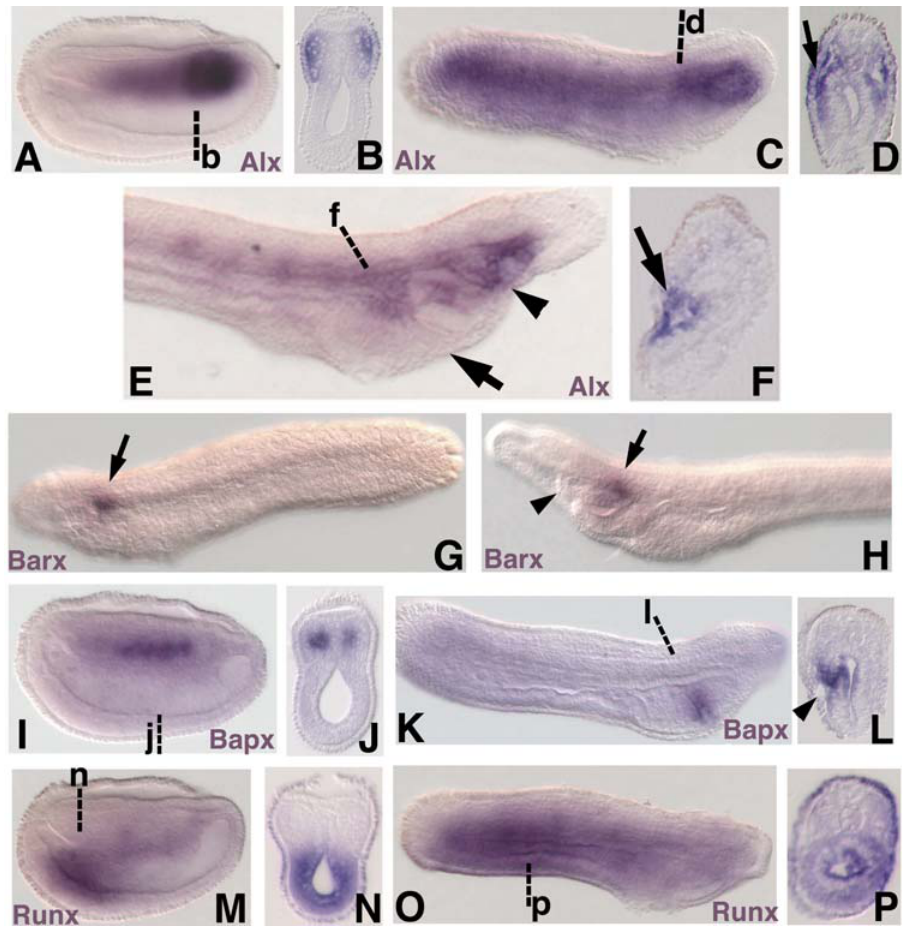
Figure 3. Expression of amphioxus Alx,Barx,Bapx, and Runxin late neurulae (15 h) and larvae. In all panels showing wholemount specimens, anterior is to the left unless otherwise indicated. ( A ) Alx expression in the lateral somites and gut diverticulae of late neurula. Strongest expression is seen in the gut diverticulae and first somites. ( B ) Section through the first somites at b in A. ( C ) Alx expression in ventral mesoderm and the anterior gut diverticulae of early larva (24 h). ( D ) Section through the pharynx at d in C showing expression in the pharyngeal mesoderm (arrow). ( E ) Alx expression in the mesoderm of the first pharyngeal arch (arrow) and the right gut diverticulum (arrowhead) of 1.5d larva. ( F ) Section through the first pharyngeal arch at f in E showing expression in mesoderm. ( G ) Anterior is to the left. Left side of an early larva focused in the plane of the ectoderm showing Barx expression in a patch of ectoderm (arrow) just caudal to the forming preoral pit. ( H ) Anterior is to the left. Left side of a 1.5d larva focused in the plane of the ectoderm showing Barx expression in a few ectodermal cells (arrow) caudal to the preoral pit (arrowhead). ( I ) Bapx expression in the medial somites of late neurula. ( J ) Section through j in I. ( K ) Bapx expression in a stripe of pharyngeal endoderm on the right side of an early larva approximating the region of the nascent first gill slit. ( L ) Section through l in K showing endodermal staining (arrowhead). ( M ) Runx expression in the posterior gut of late neurula. ( N ) Section through n in M. ( O ) Runx expression in the gut of early larva. ( P ) Section through p in O.